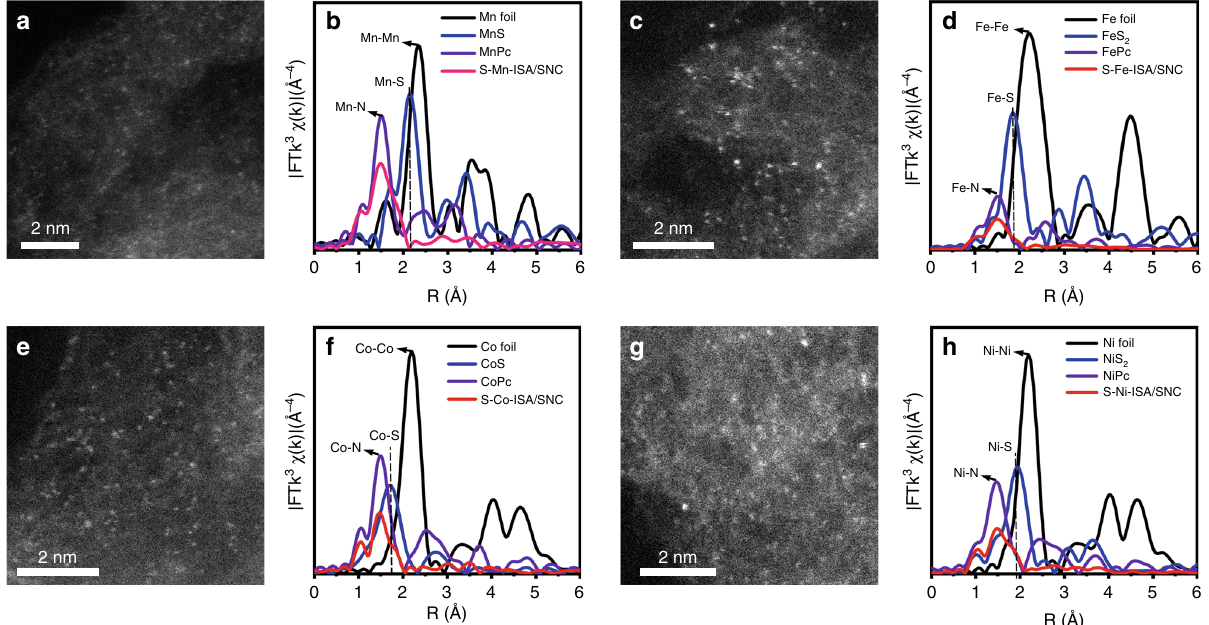
Fig. 6 HAADF-STEM and FT-EXAFS characterization of S-M-ISA/SNC (M = Mn, Fe, Co, Ni). HAADF-STEM images of a S-Mn-ISA/SNC, c S-Fe-ISA/ SNC, e S-Co-ISA/SNC and g S-Ni-ISA/SNC. FT-EXAFS spectra of b S-Mn-ISA/SNC, d S-Fe-ISA/SNC, f S-Co-ISA/SNC and h